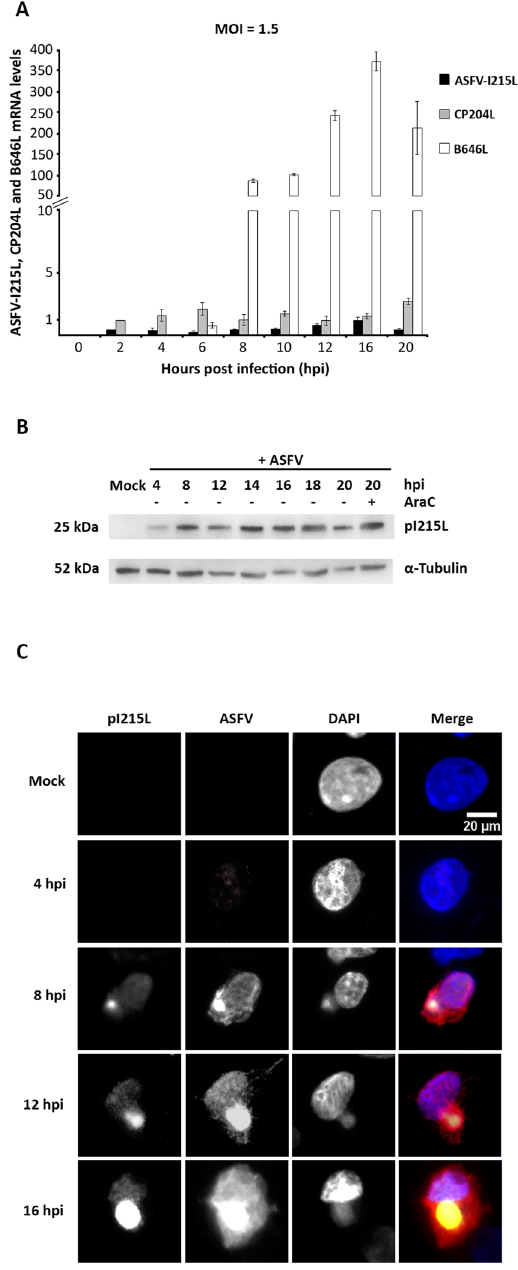
Figure 2. ORF I215L encodes an early viral protein that accumulates in viral factories. (A) I215L transcripts were detected from 2 hpi onwards showing a maximum peak at 16 hpi. The mRNA levels of CP204L (vp32) and B646L (vp72) were measured in parallel and used as controls of early and late viral gene expression, respectively. Results are shown as mean ± standard error by dividing the number of transcripts of each viral gene by the number of Cyclophilin A mRNA molecules (housekeeping gene), obtained from three independent experiments run in duplicate. (B) ASFV-I215L gene encodes for an early protein detectable from 4hpi onwards, with expressing levels unchanged by the AraC treatment. Vero cells infected with ASFV/Ba71V isolate (MOI of 5) and harvested at the indicated time points. The cytosine arabinoside treatment (AraC, 50 µ g/ml) was performed after the initial viral adsorption period (1 hour) and cells were collected at 20 hpi. (C) Vero-infected cells (MOI = 2) were fixed (4, 8, 12 and 16 hpi), immunostained and analyzed by fluorescent microscopy. pI215L was detected from 8 hpi onwards, being recruited to viral factories, co-localizing with other viral proteins (e.g. pA104R and VP72, data not shown) and showing a faint distribution pattern in cell nucleus. In the merged images, pI215L, ASFV and DAPI staining is shown in green, red and blue, respectively. Representative images of at least three independent experiments are